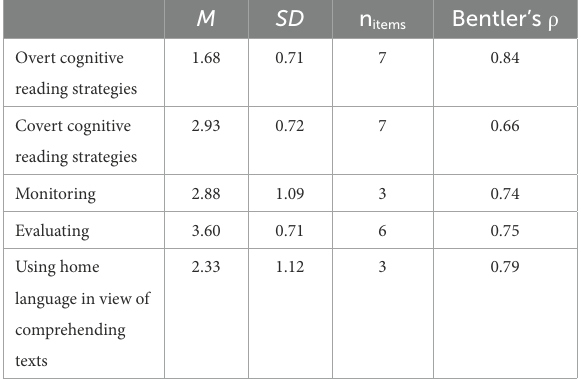
TABLE 4 Descriptive statistics of the RCSQ subscales (sample 2).